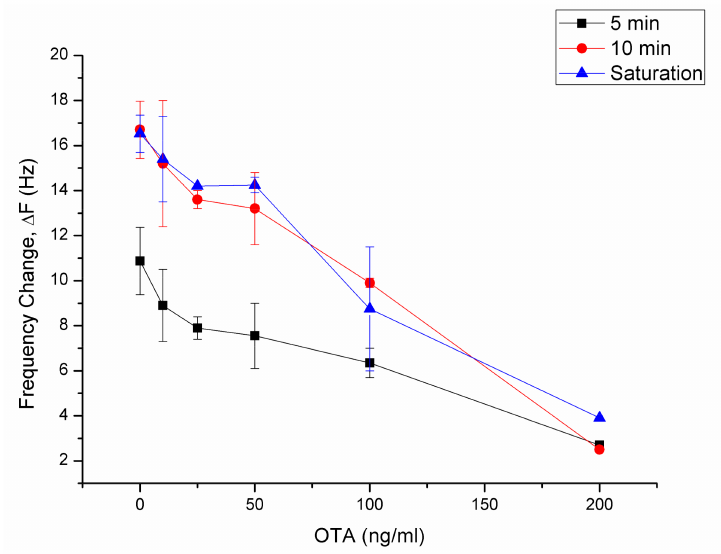
Figure 7. Sensorgrams showing sensor response at different OTA concentrations: 0.025 mg/mL 10F4 was applied to sensor surface until the sensorgram reaches to saturation, then the surface was washed with PBS.